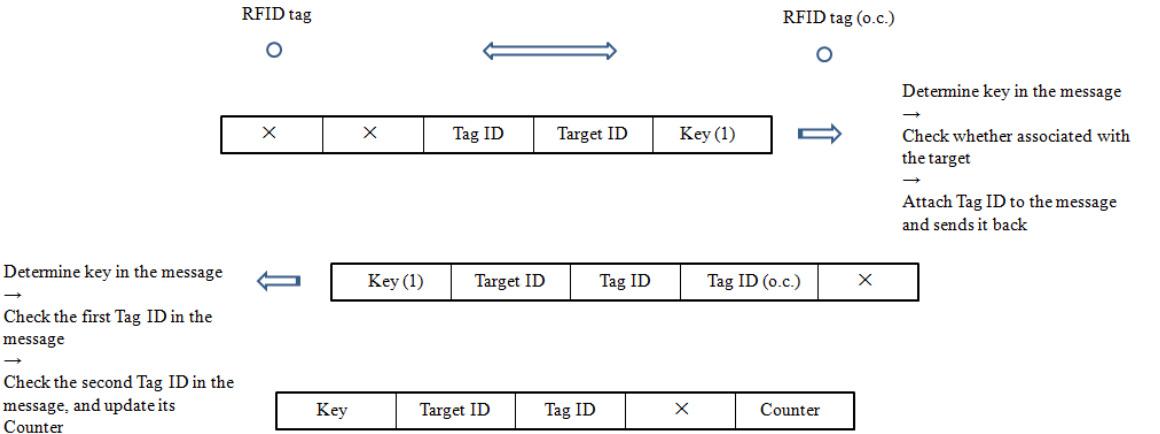
Figure 8. Link counting process of RFID tag in the cluster.